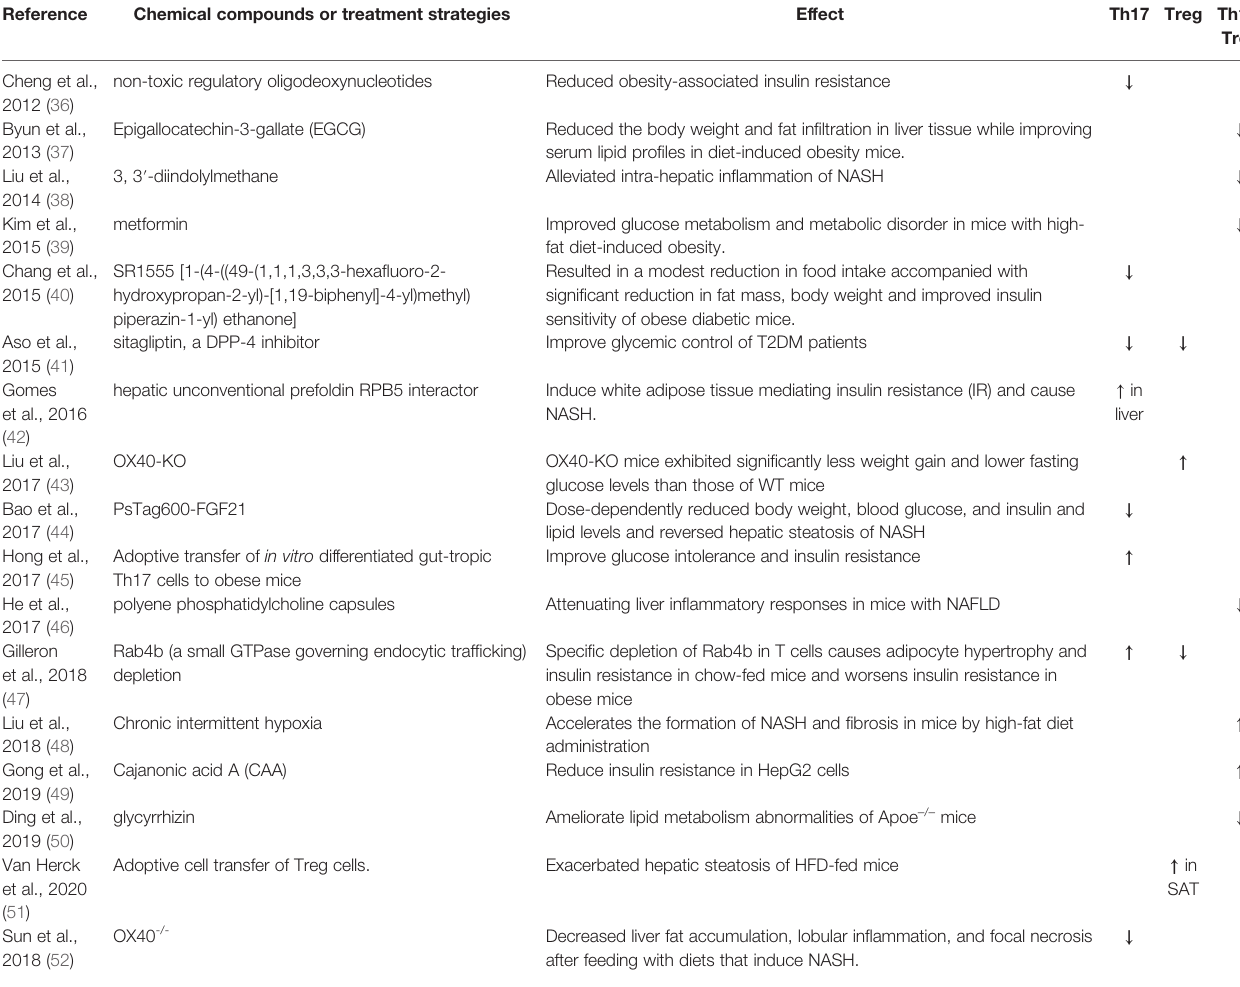
TABLE 1 | Chemical compounds or treatment strategies regulate metabolic disorders via changing Th17 or Treg